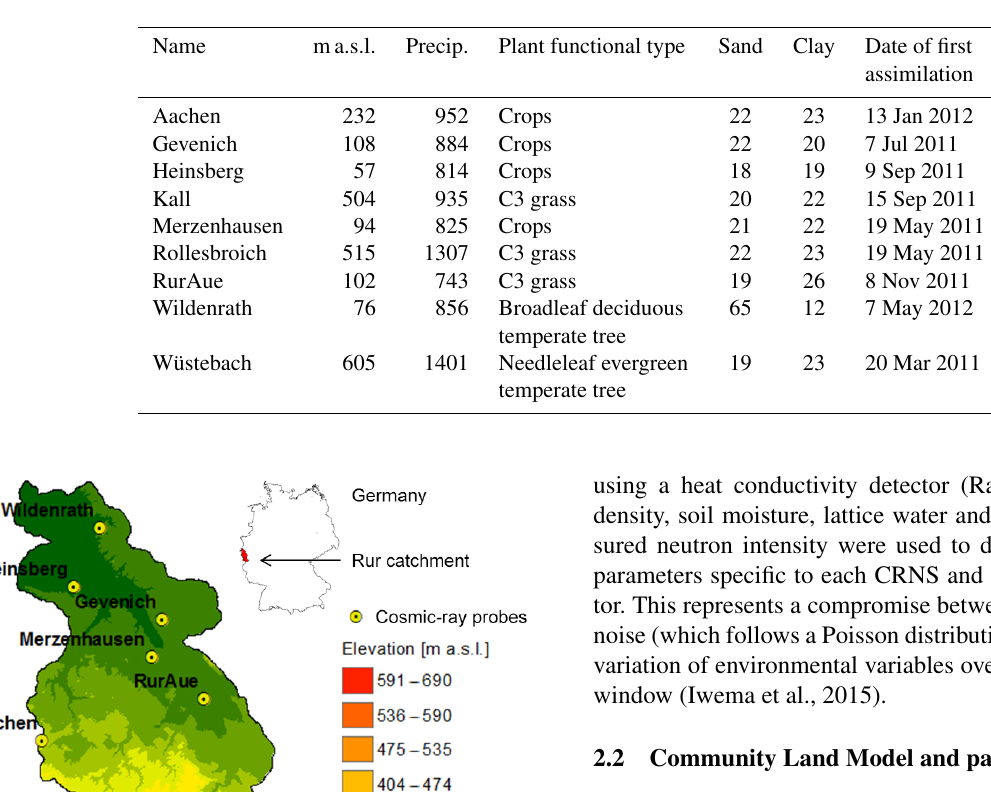
Table 1. Site information on elevation (ma.s.l.), average annual precipitation (mmyr − 1 ), CLM plant functional type (Bonan et al., 2002), sand content (%), clay content (%) and the date of the first SWC retrieval assimilated.